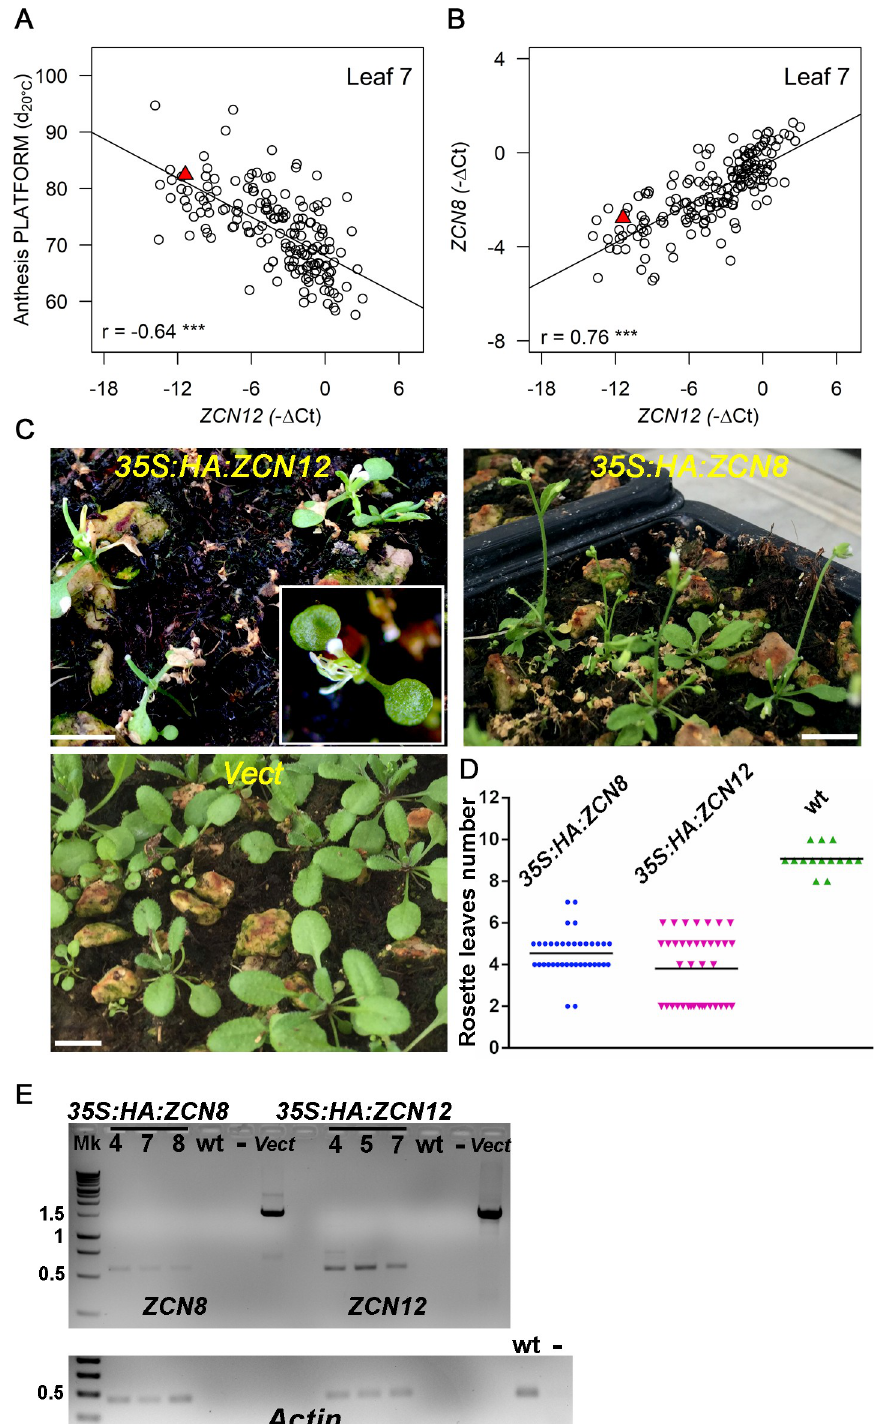
Fig 2. ZCN12 is a novel maize florigen co-regulated with ZCN8 . ZCN12 expression correlates with anthesis time (platform experiment 2014), (A), and with ZCN8 expression (B). Genotypic values are BLUEs. Pearson’s correlation coefficients are indicated with their significance ( ��� , p < 10 − 4 ). The red triangle represents genotypic values for the reference line B73. In (A) and (B), n = 173. (C) Arabidopsis T1 plants overexpressing ZCN12 but not ZCN8 show an extreme early flowering phenotype compared to empty vector transformation (Vect.); plants were photographed 3 weeks after sowing, horizontal bar, 1 cm. (D) ZCN8 and ZCN12 T1 over-expressing plants are earlier flowering than wild